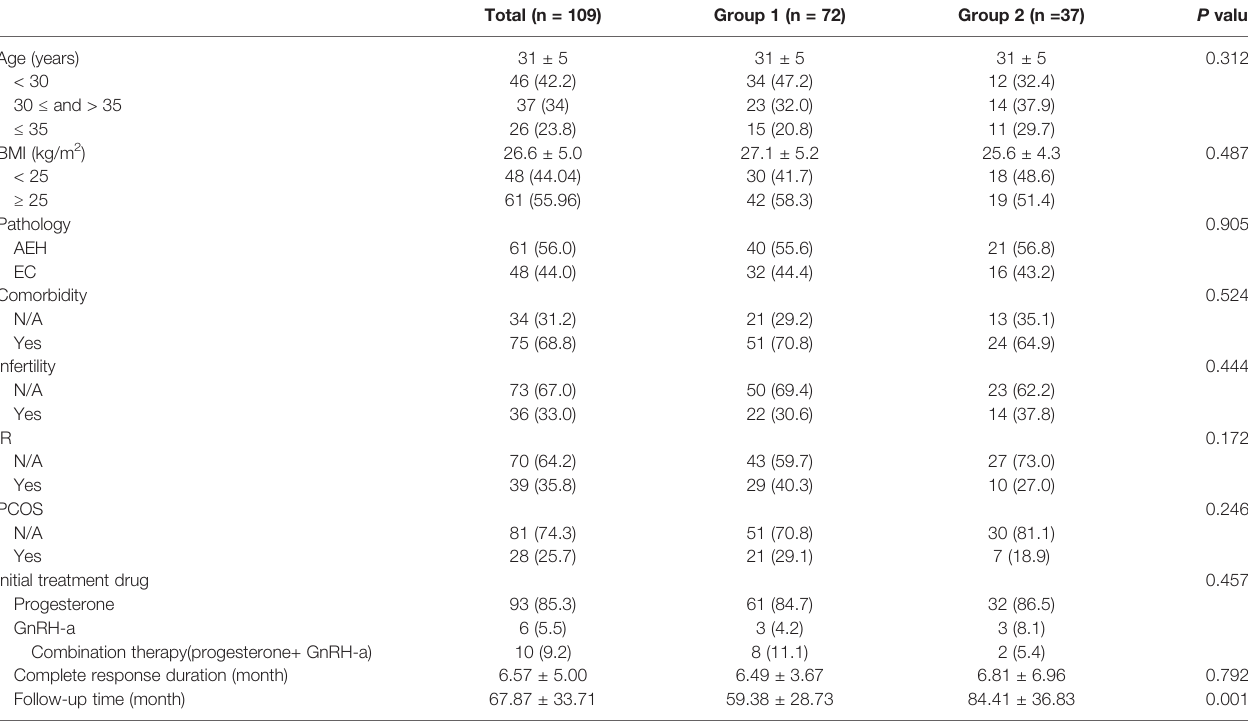
TABLE 1 | General conditions of patients with atypical endometrial hyperplasia and endometrial carcinoma who achieved complete response